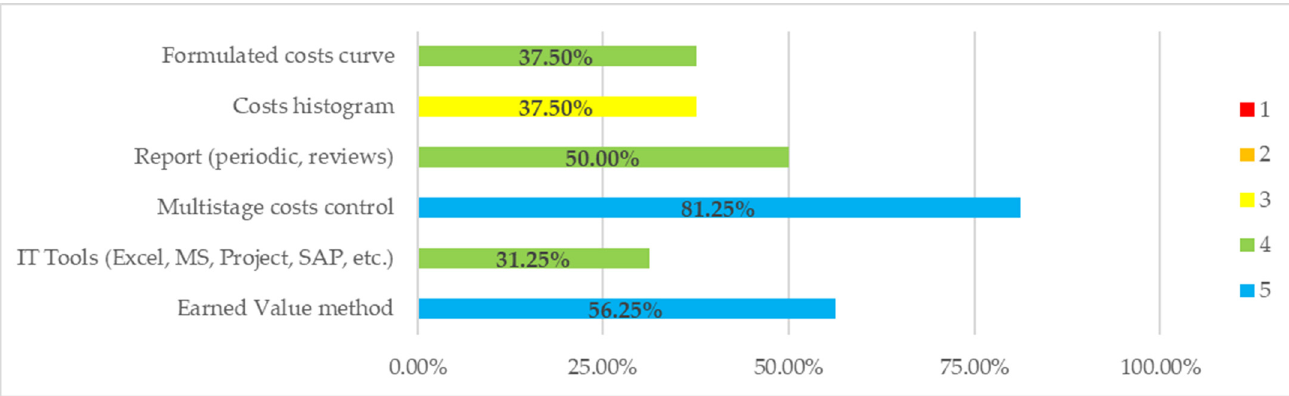
Figure 3. Evaluation of the effectiveness of the methods, techniques and tools used for the cost control. Source: own elab.